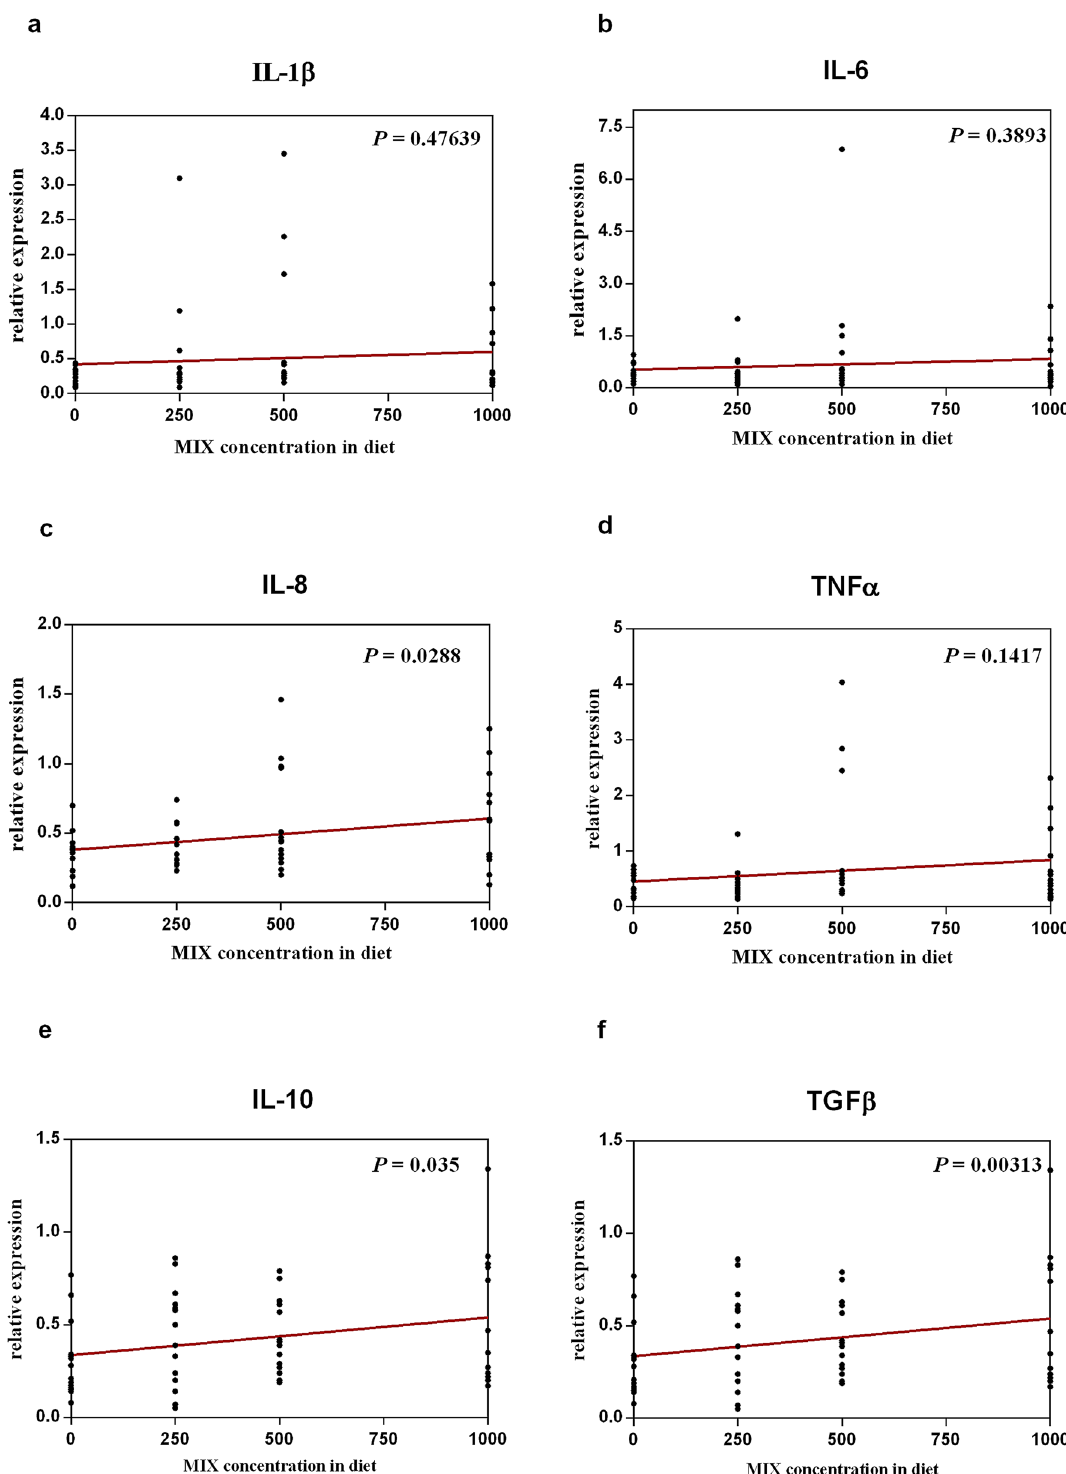
Figure 1. Linear regression analyses showing the effect of the dietary increasing level of OA and NIC on the relative expression of six cytokines genes ( a – f ) involved in the immune and inflammatory response at intestinal level at T1 (day